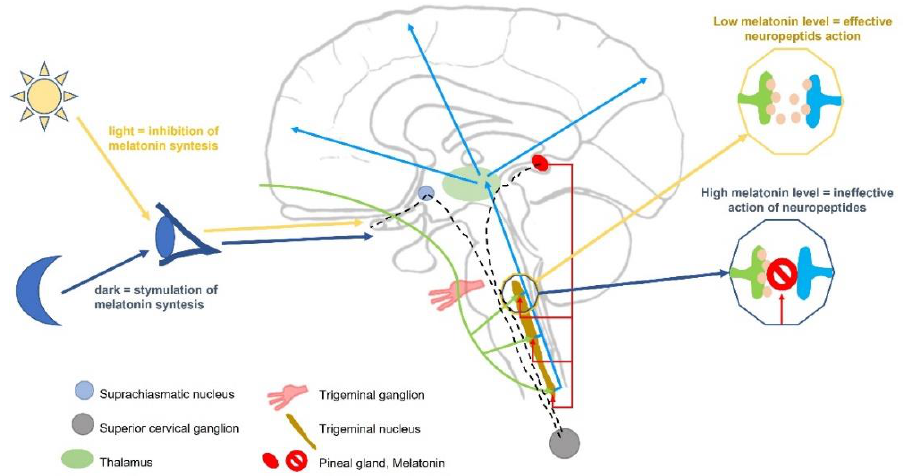
Figure 1. The potential role of melatonin in the pathogenesis of migraine modified according to: [29,30].